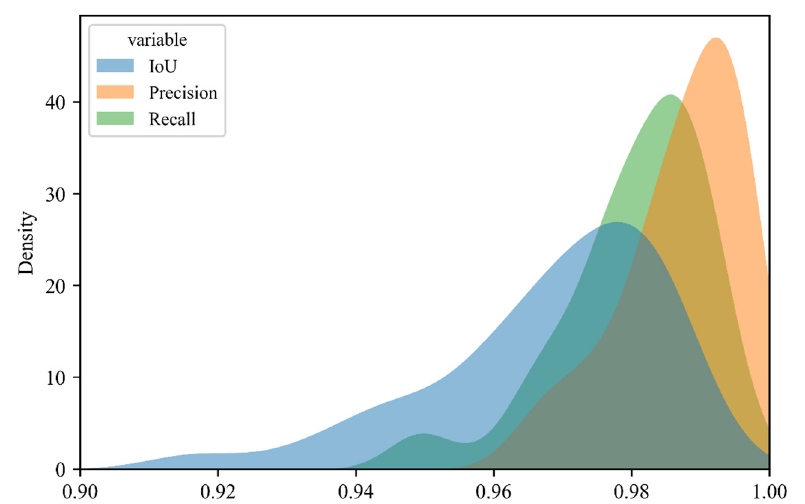
Figure 7. Distribution of the transformation accuracy indicators for all 112 lotus plots. For each plot, only ROI-centered raw images (minimum Euclidean distance between ROI center and raw image center) were selected and the references manually marked.